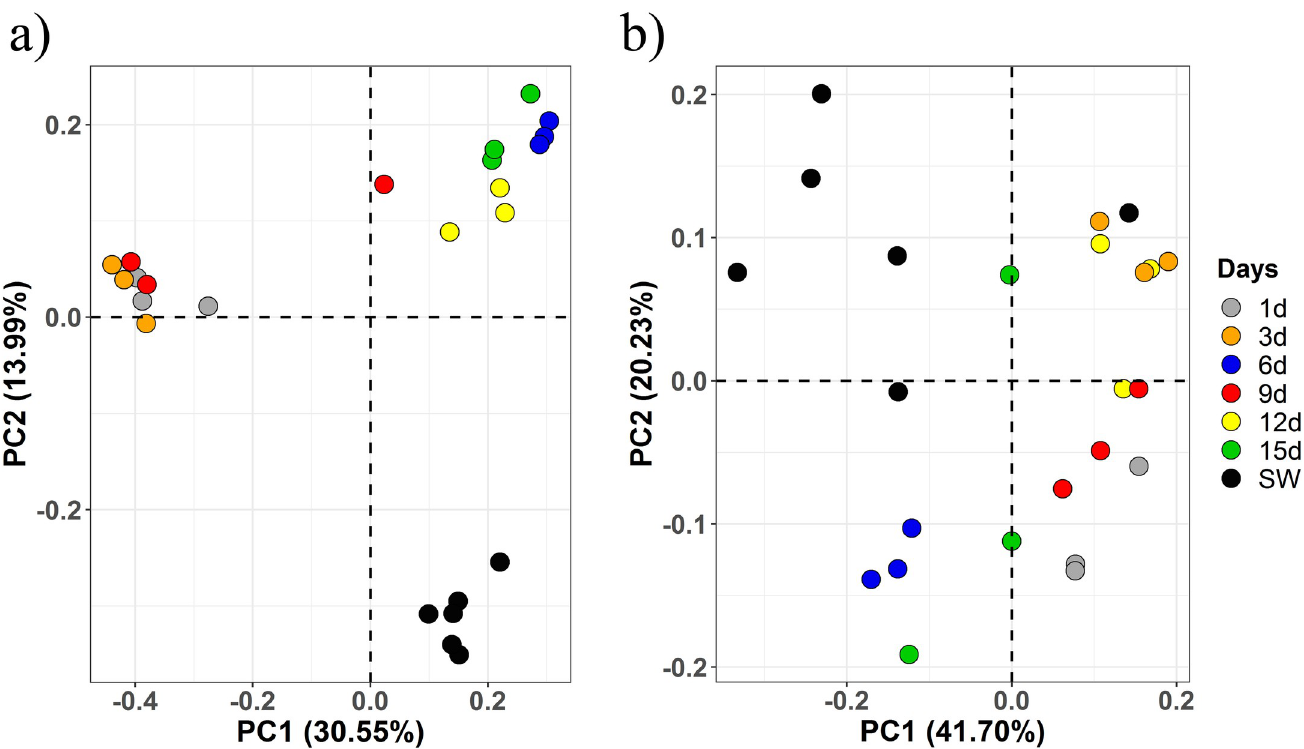
Fig 3. Principal coordinate analysis (PCoA) plots showing variation in biofilm-forming and seawater-associated bacterial communities collected for consecutively 15 days from the southern coastal region of India. a) PCoA plot displaying clustering pattern based on unweighted UniFrac (take presence/absence matrix in the account). b) PCoA plot displaying clustering pattern based on weighted UniFrac (take abundance in the account). Coloured circles in the PCoA plots represent the days of marine biofilms and seawater sampling.